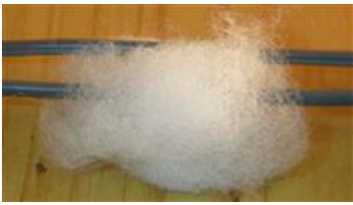
Figure 11. Combustibles placed on the sample cord.